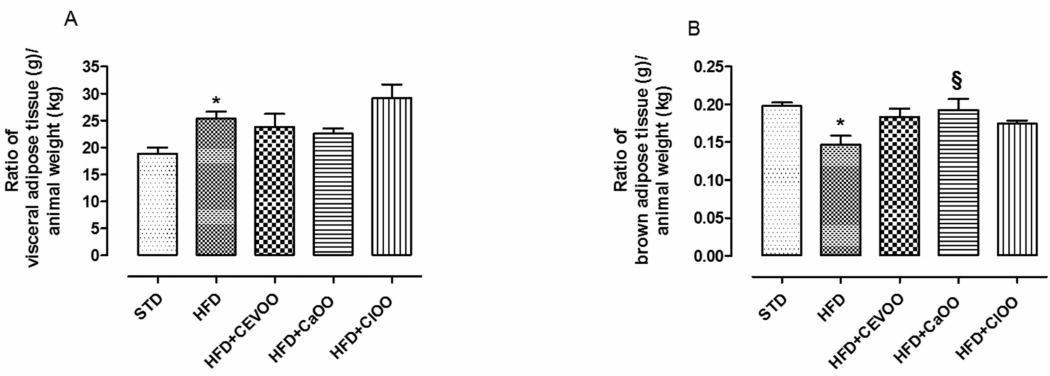
Figure 4. ( A ) Ratio of adipose tissue (g) in relation to animal weight (kg) after three weeks of treatment with di ff erent diets. ( B ) Ratio of brown adipose tissue (g) in relation to animal weight (kg) after three weeks of treatment with di ff erent diets. * indicates a statistically significant di ff erence between the HFD group and the STD group. § indicates statistically significant di ff erence between HFD and HFD + CEVOO or HFD + Ca OO or HFD + Cl OO. Single symbol corresponds to p <